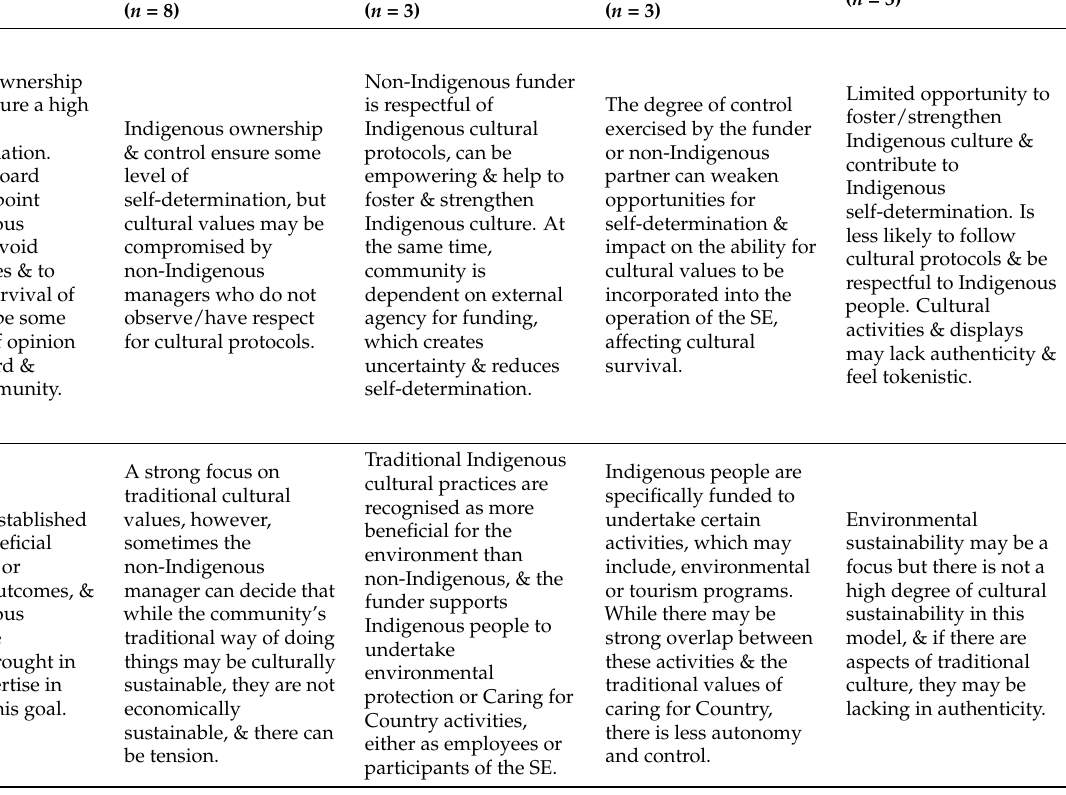
Themes & Cultural